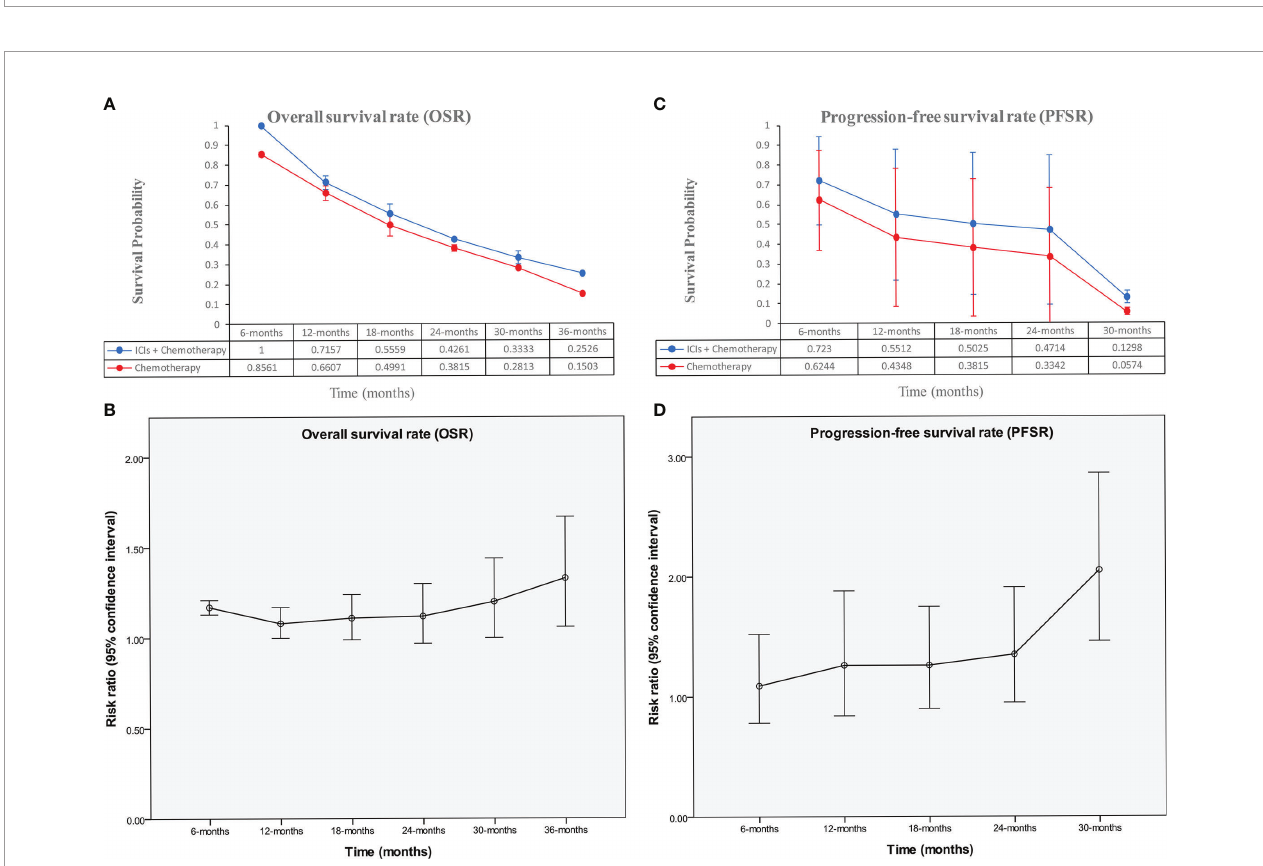
FIGURE 3 | Comparisons of OSR (6 – 36 months, A, B ), and PFSR (6 – 30 months, C, D ) associated with ICIs+Chemotherapy versus Chemotherapy according to survival